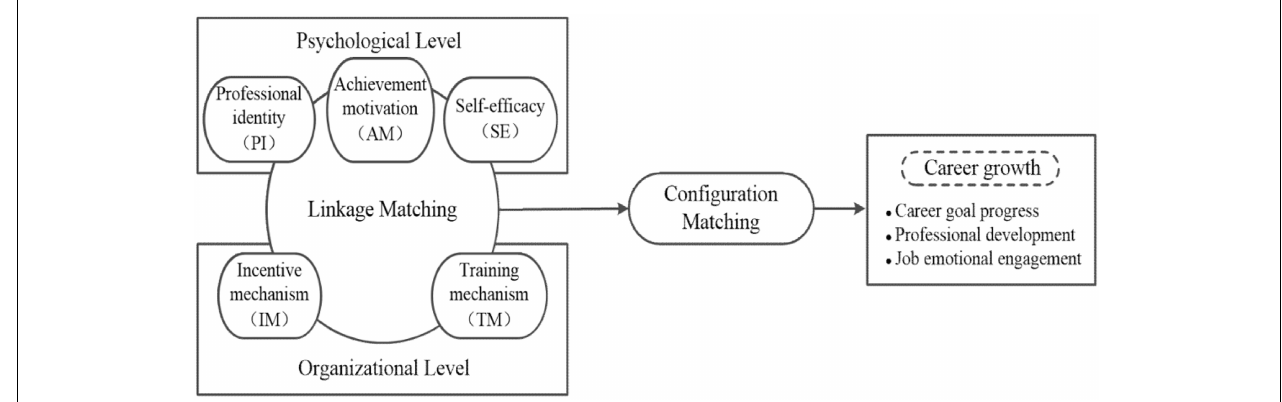
FIGURE 1 | Career growth driving mechanism model.